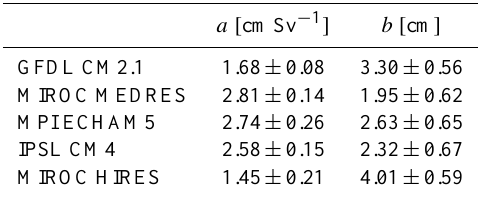
Table 3. Results of a linear regression of DSLR vs. AMOC weak- ening ( y = ax + b ) for a AR4 model ensemble derived from SRES A1B scenario runs and for the grid-point closest to NYC from